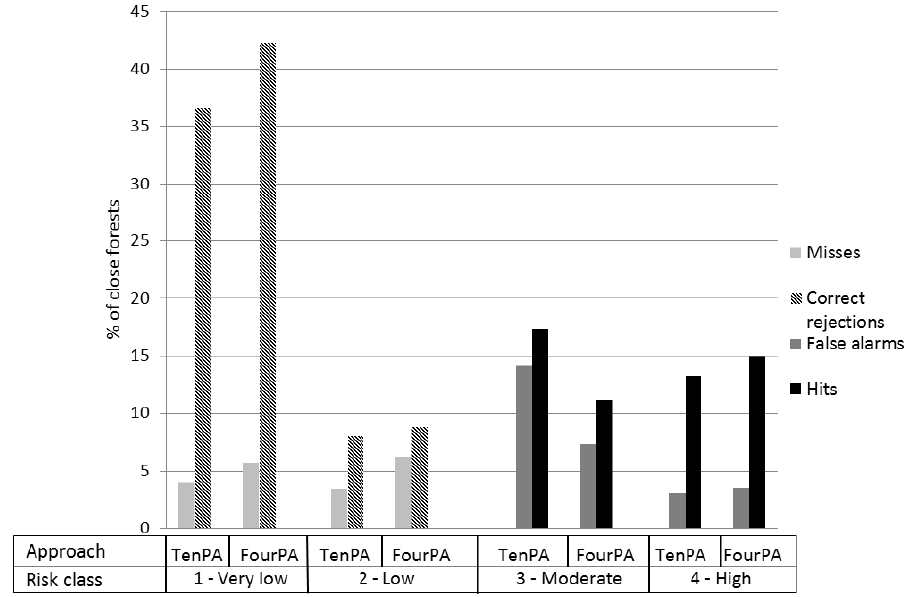
Figure 5. Elements of agreement and disagreement divided by the four classes of risk (i.e., very low, low, moderate and high). The accuracy components for both the modeling alternative with 10 (TenPA) and four (FourPA) predictors are reported for each risk